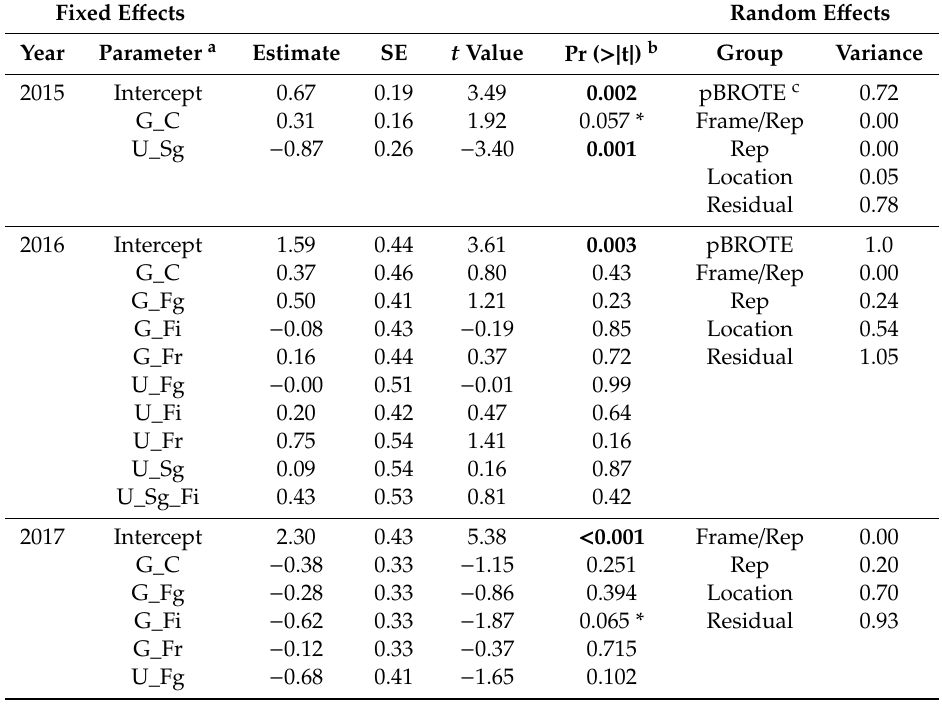
Table 4. The response of Bromus tectorum seed production to grazing and / or herbicide treatments, analyzed using a linear mixed e ff ects model. All treatments (parameters) are with respect to the ungrazed control treatment (U_C), which is the intercept in the model. In 2015 only the grazed (G) and ungrazed control, and the spring applied herbicide treatment results are shown, because fall herbicide application had not yet occurred. Results are based on log transformed B. tectorum seed